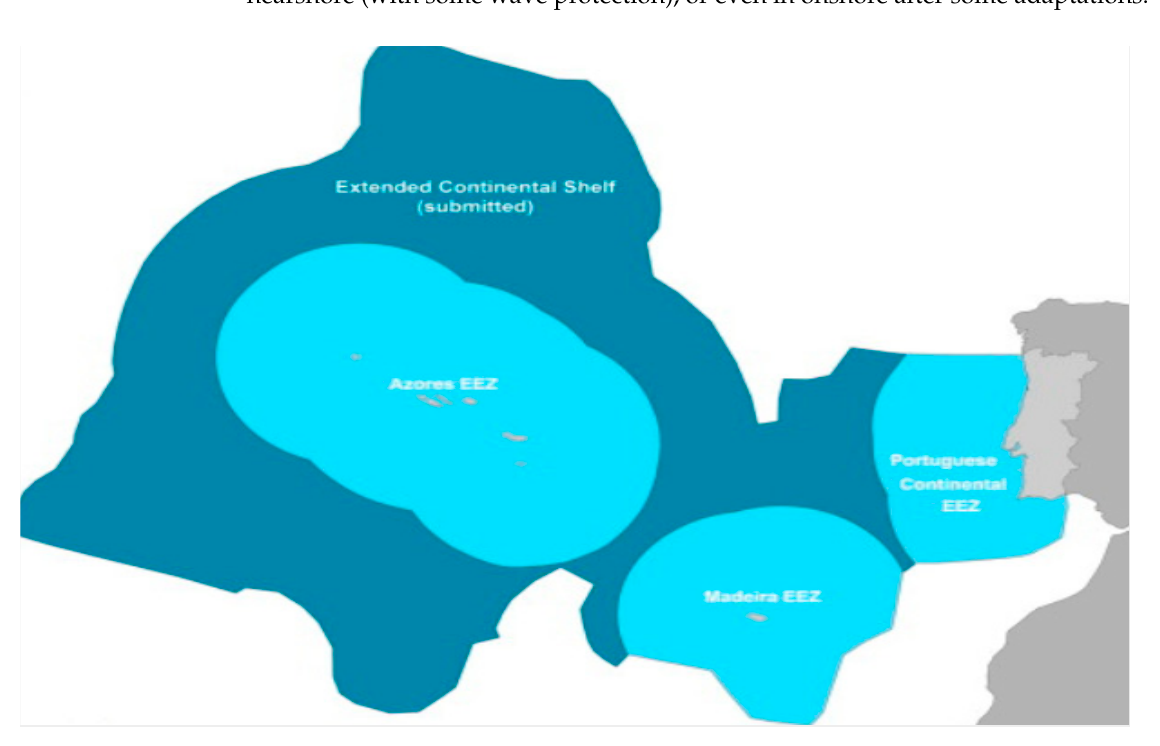
Figure 21. Portugal’s Exclusive Economic Zone (EEZ).